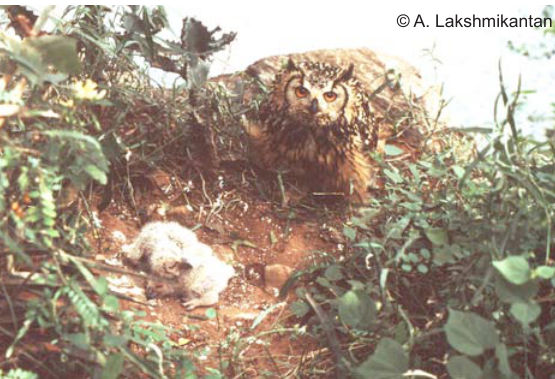
Image 5. Brooding female left the nest and began erecting body plumage, hissing, bill clapping and giving the alarm call (Human distance from nest ca. 24-30